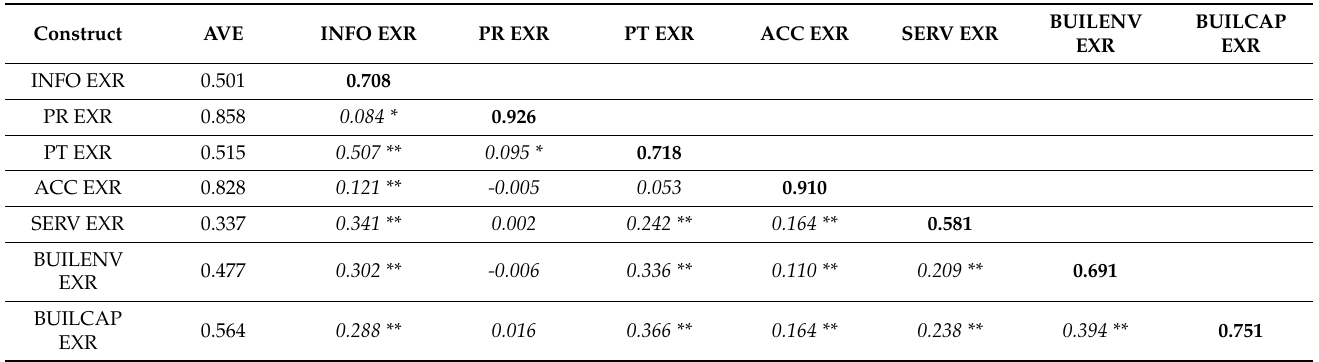
Table 7. Convergent, discriminant, and divergent validity for the independent